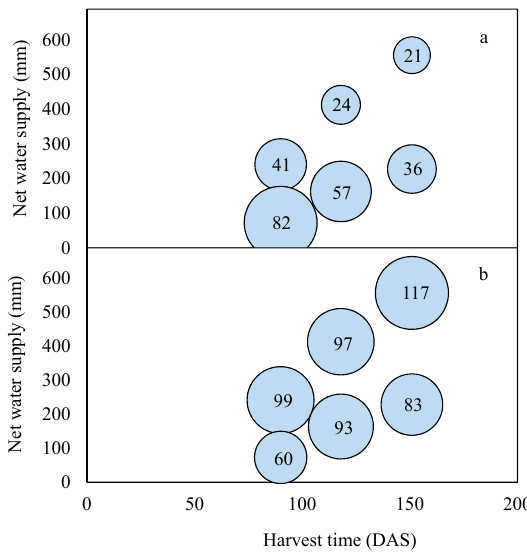
Figure 3. ( a ) Amount of land (thousand hectares) and ( b ) irrigation water (Mm 3 ) needed to supply an 85,000 m 3 ·yr − 1 ethanol plant with biomass sorghum, based on harvest time and net water supply.